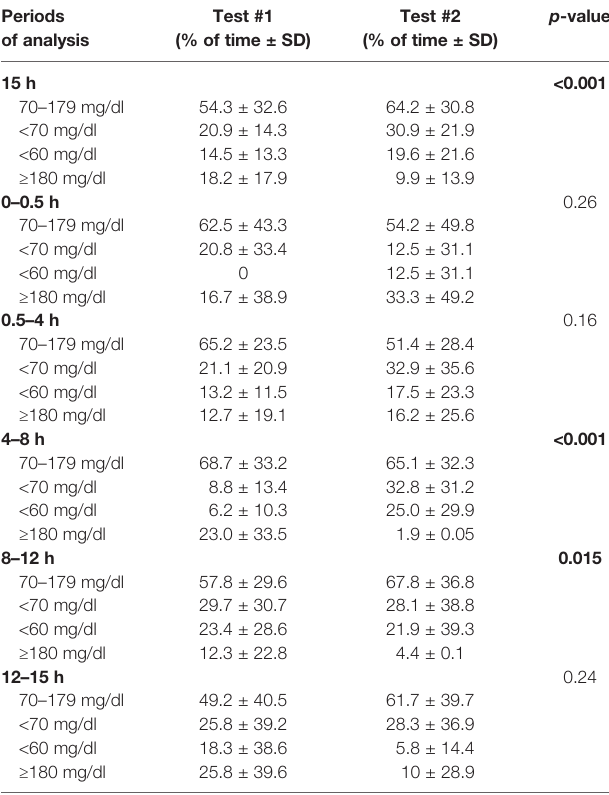
TABLE 2 | Glucose variations during Test #1 and #2 sessions. Periods of